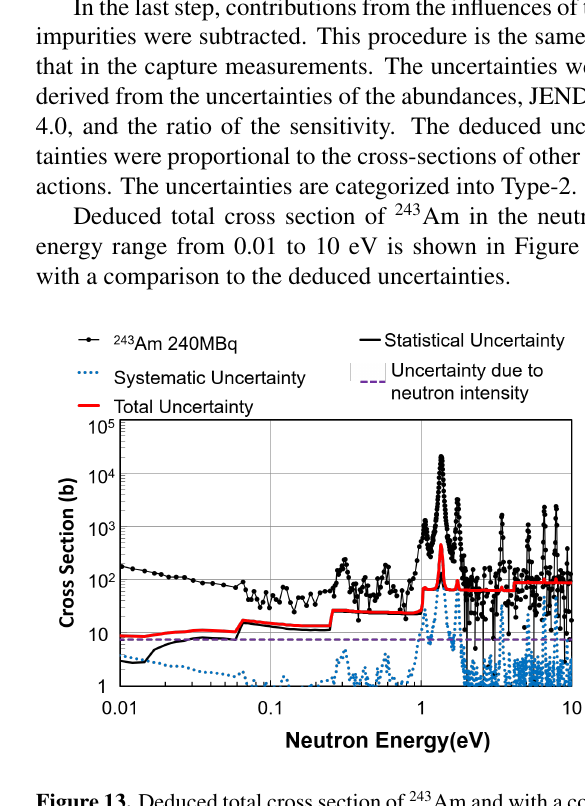
Figure 13. Deduced total cross section of 243 Am and with a com- parison to the deduced uncertainties in the neutron energy range from 0.01 to 10